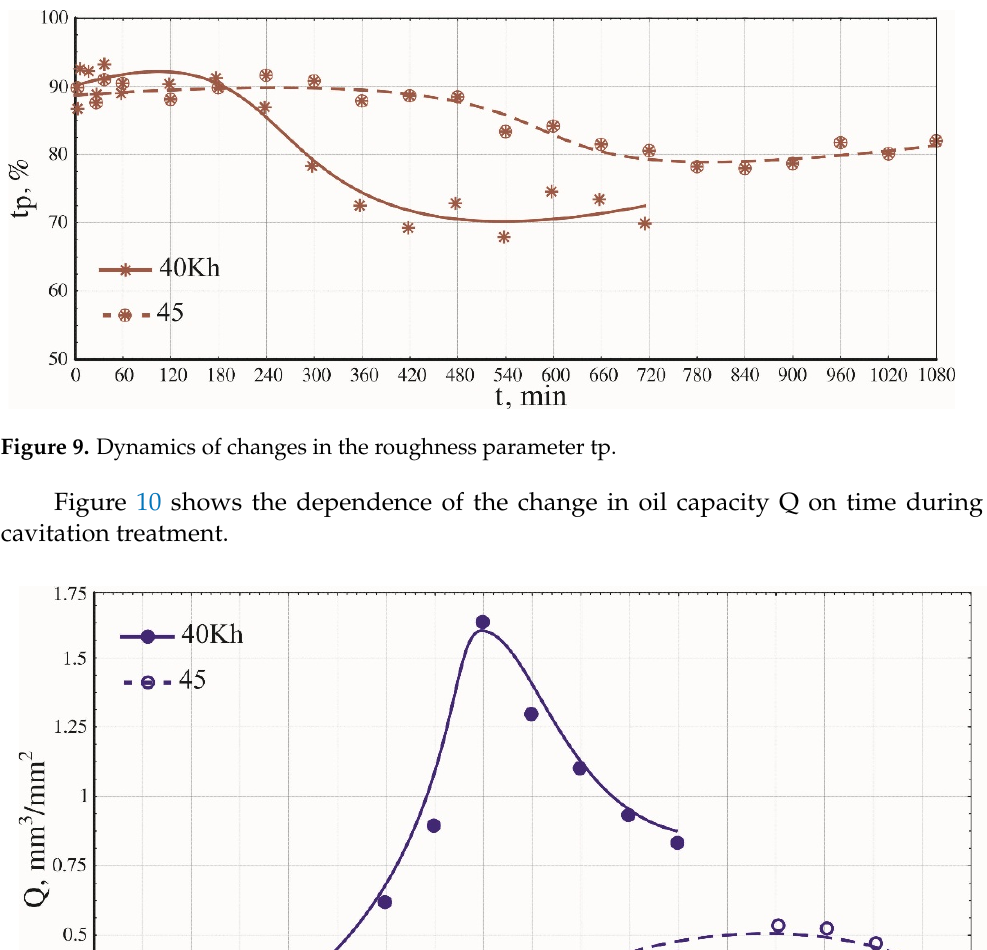
Figure 8. Dynamics of changes in the roughness parameters Sm and S.